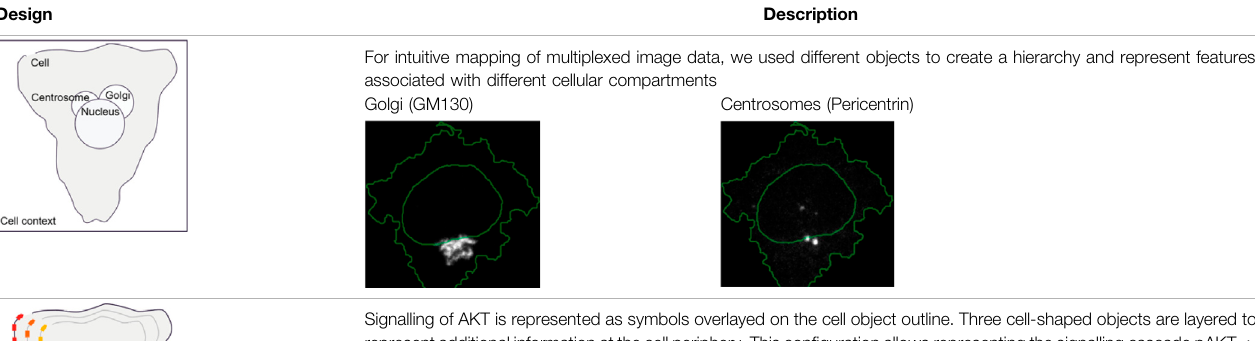
TABLE 2 | List of design decisions (objects and visual elements) used in Figure 3 .